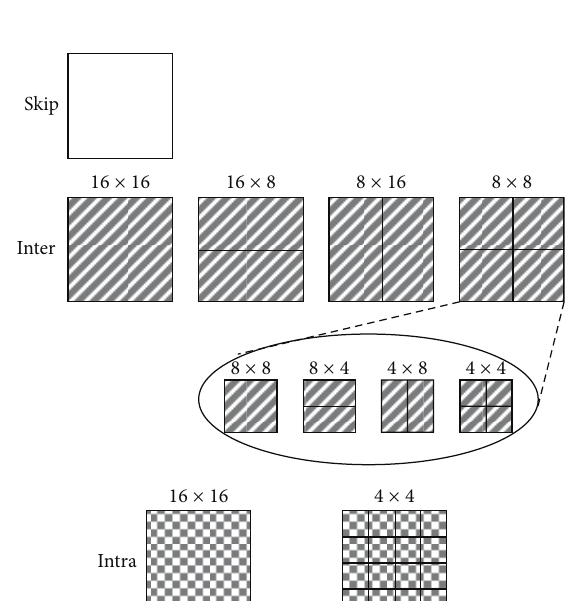
Figure 12: Prediction modes in H.264/AVC.